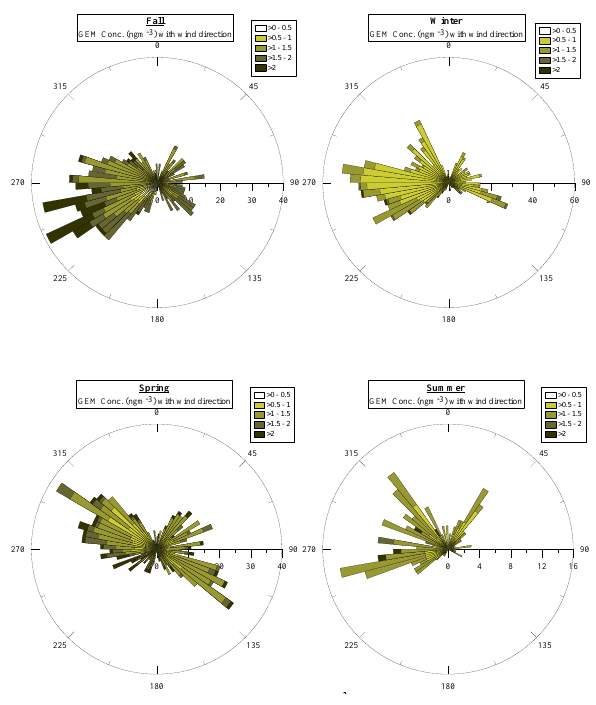
Figure 5: Pollution roses of GEM concentrations (ngm −3 ) for each season measured at Elora, ON during the study period (01 Nov 2006 to 29 Jul 2007). The concentrations (hourly average) intervals are plotted against the frequency of occurrence on the radius axis. Fig. 5. Pollution roses of GEM concentrations (ngm − 3 ) for each season measured at Elora, ON during the study period (1 November 2006 to 29 July 2007). The concentrations (hourly average) inter- vals are plotted against the frequency of occurrence on the radius